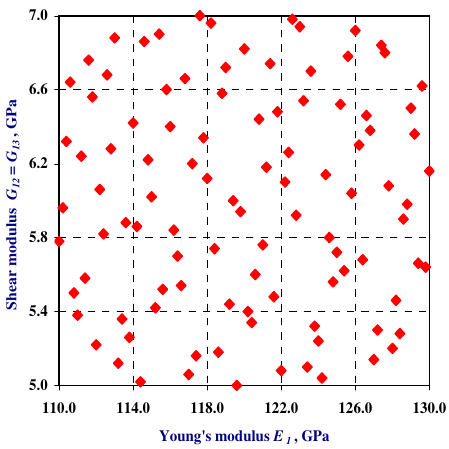
Fig 3. Plan of experiment: 2D view